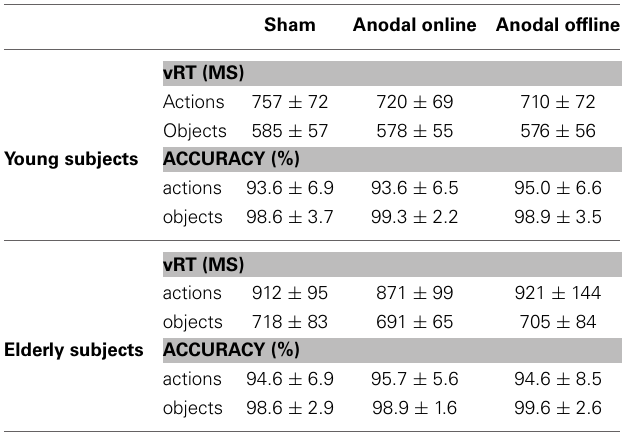
Table 3 | Verbal reaction time (vRT) and accuracy for young and elderly subjects in the three experimental conditions. Sham Anodal online Anodal offline